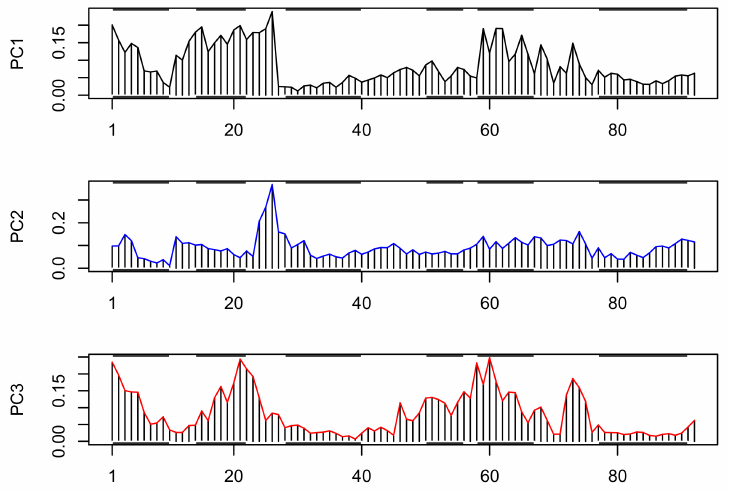
Figure 6. The loadings of the first three PCs. The X -axis represents the index of the residues in the multiple sequence alignment in which gaps were removed. The horizontal bars in black represent helical